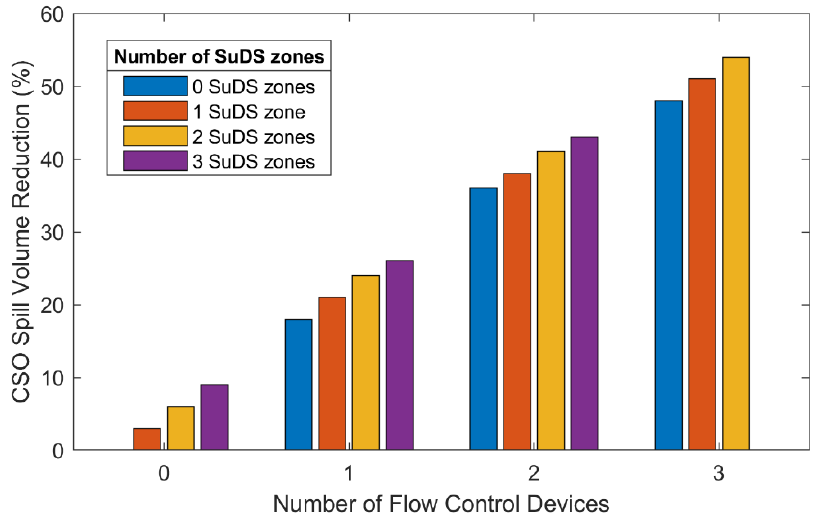
Figure 7. CSO spill volume reduction obtained in the Zona Central catchment for different combinations of intervention measures (the CSO spill volume in the baseline network was equal to 2287 m 3 ). Table 4. Comparison between CSO spill volume reductions obtained by simultaneous and separate optimizations of FCD and SuDS locations within the Zona Central catchment.